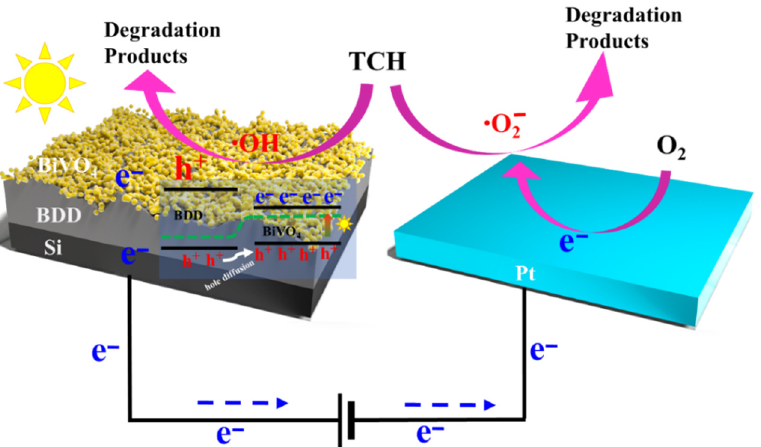
Figure 7. Schematic illustration of the band diagram and PEC degradation occurring at the BiVO 4 /BDD heterojunction photoanode under a forward bias and light irradiation.